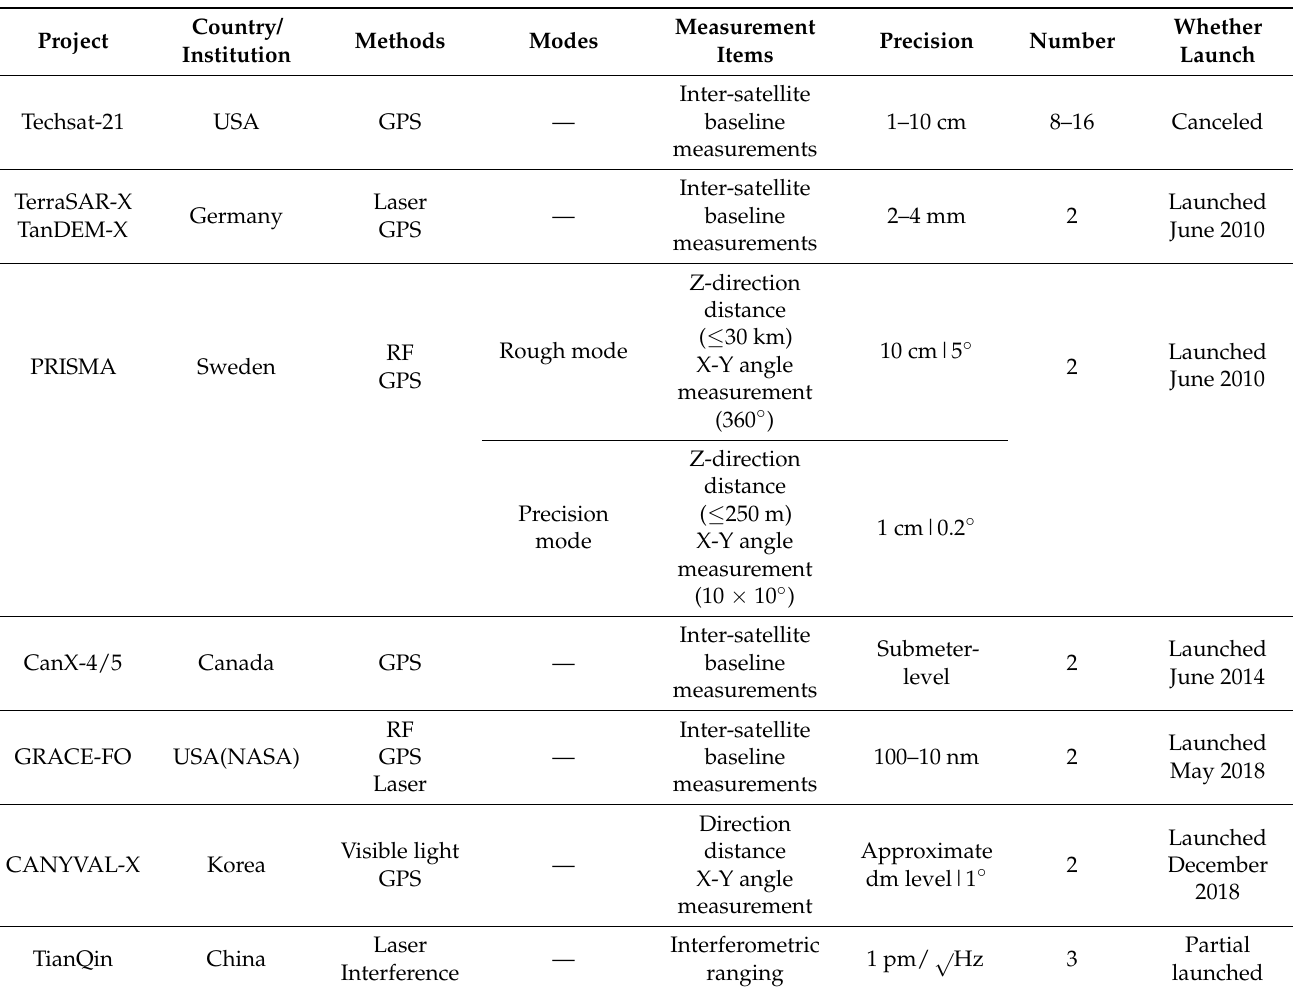
Figure 12. Time analysis chart of the distributed spacecraft precision formation flying projects. Table 6. The precise formation parameters of each